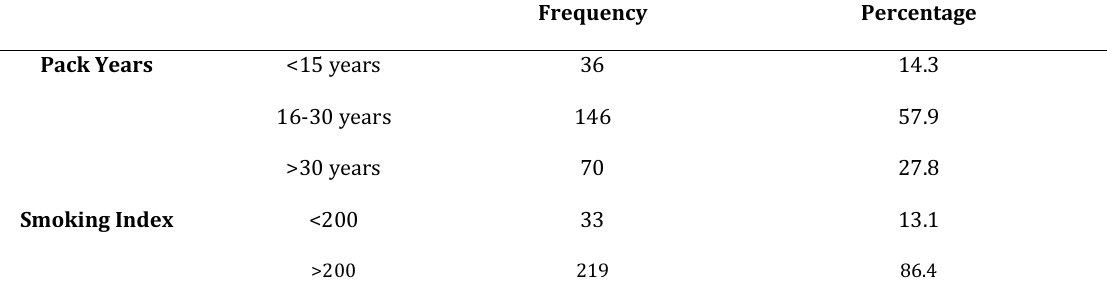
Table 1: Distribution of pack years and smoking index among the smokers (n=252)